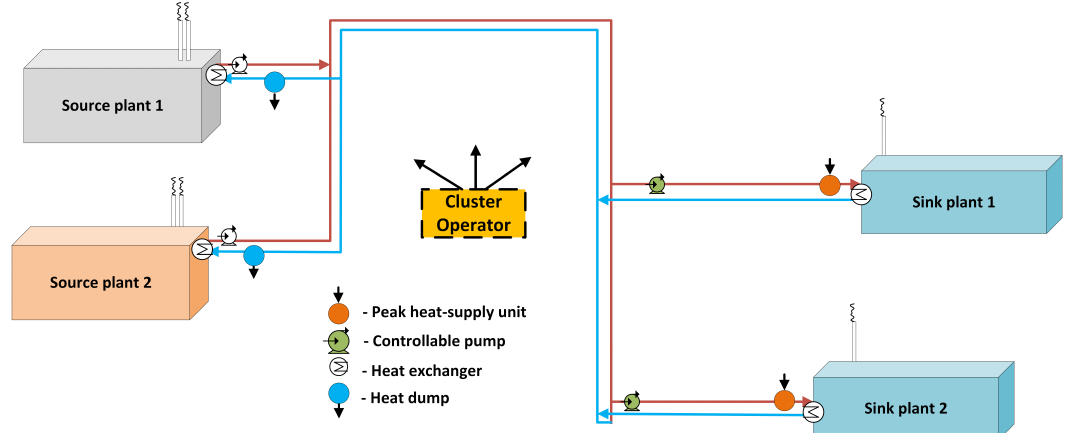
Figure 7. Layout of comparison case consisting of surplus-heat exchange with no thermal storage unit in an industry cluster with two source plants with surplus heat and two sink plants with heat